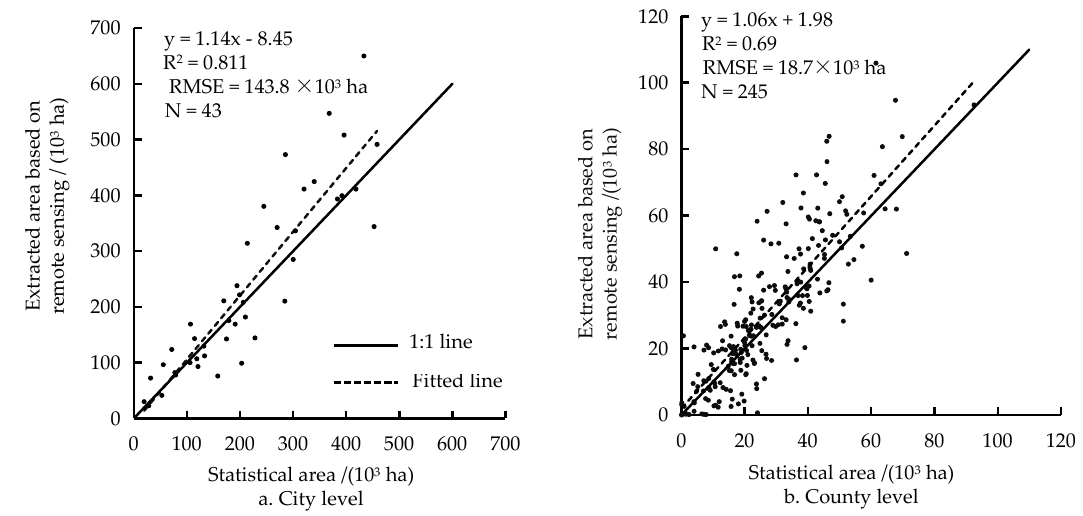
Figure 11. Correlation between the extracted area based on remote sensing and statistical area of summer maize in Huanghuaihai Plain in 2012.